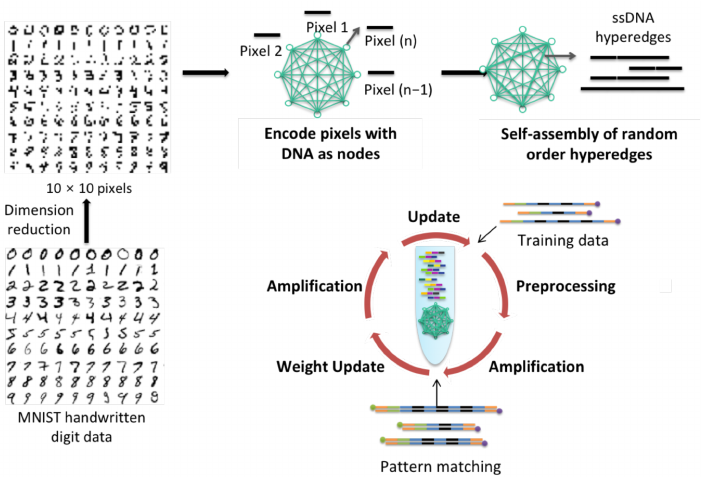
Figure 1. Hypernetwork with nodes and hyperedges with a conceptual overview of molecular machine learning with DNA processes. Each node represents a pixel which is encoded to a unique DNA sequence. These pixel DNA are self-assembled to form random order